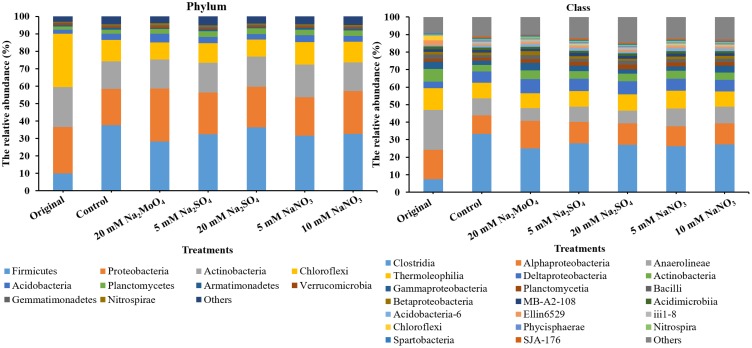
The bacterial community structure at the phylum and class level. Original, soil sample was on day 0 and Other treatments, samples were on day 40.